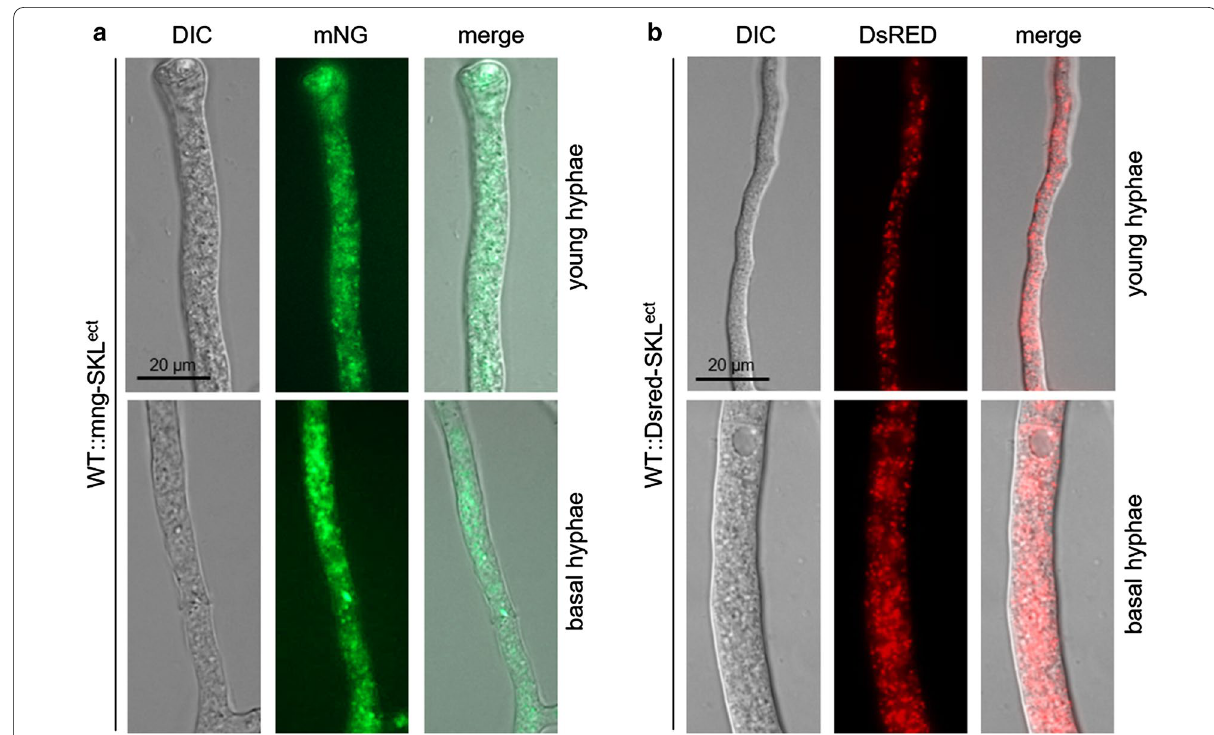
Fig. 5 Fluorescence microscopy of peroxisomal-targeted mNG and DsRed in S. macrospora . a Hyphae of a strain transformed with pmng-SKL. b Hyphae of a strain transformed with pDsRed-SKL. The exposure time for image acquisition of both strains was set to be the same. Scale bar, 20